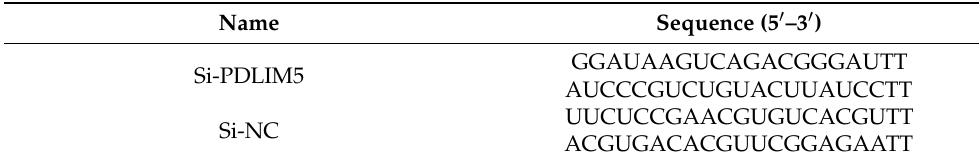
Table 1. The sequences of RNA oligonucleotide and plasmid.